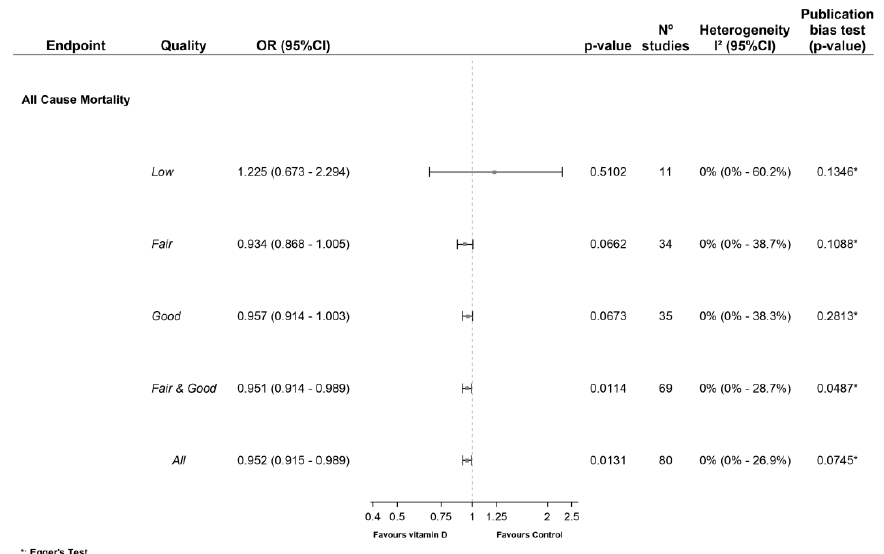
Figure 2. Forest plot of the effect of vitamin D supplementation on all-cause mortality.